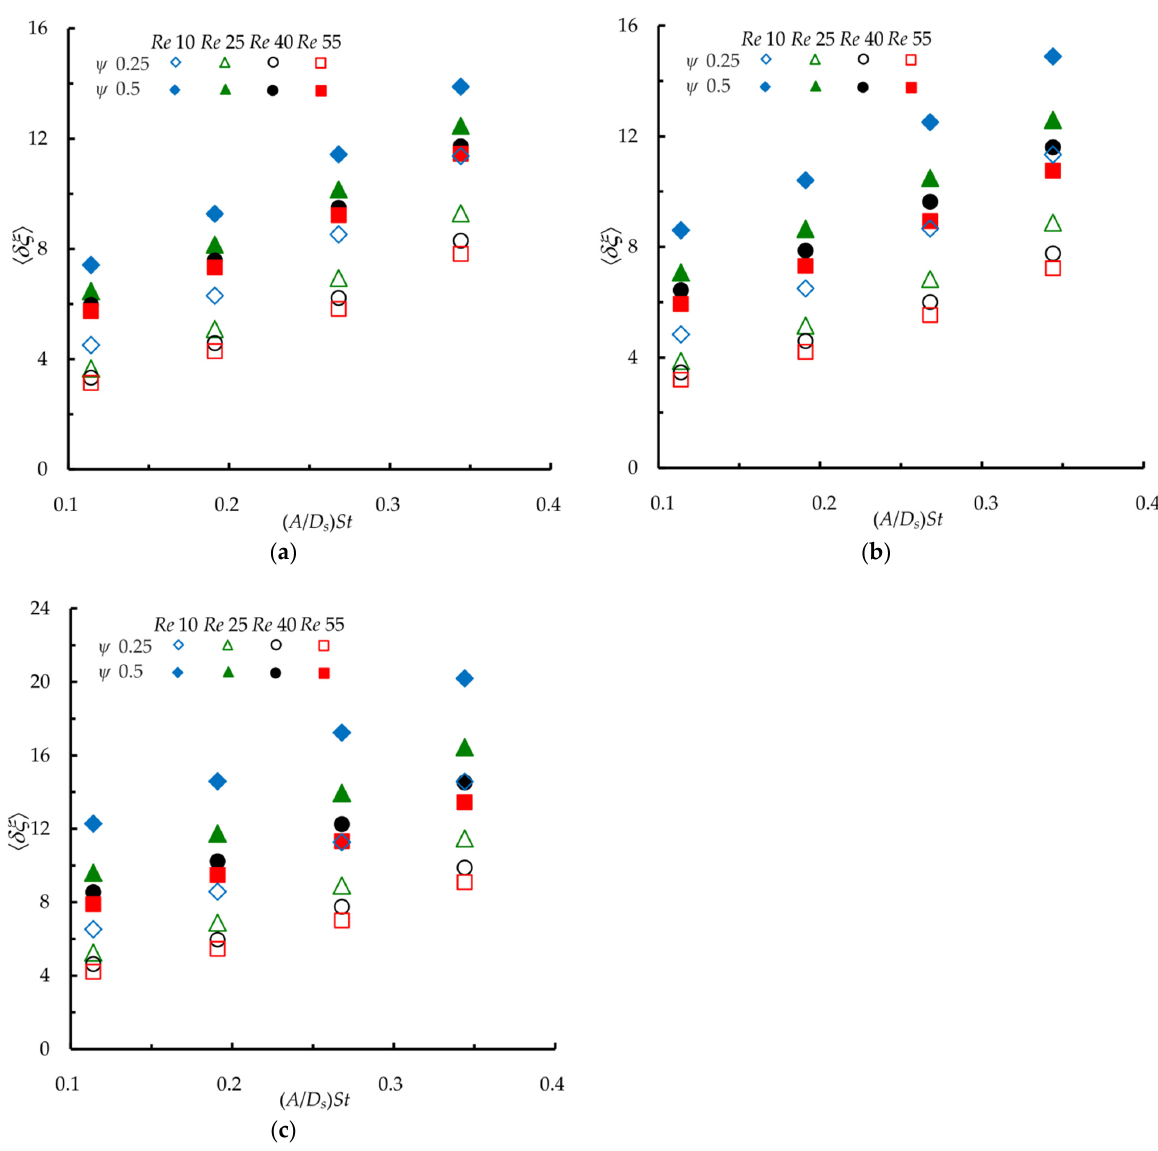
Figure 15. The effect of the pulsating flow on the friction factor ratio averaged over one period of pulsation for different porosities: ( a ) ε = 0.743. ( b ) ε = 0.864. ( c ) ε = 0.954.